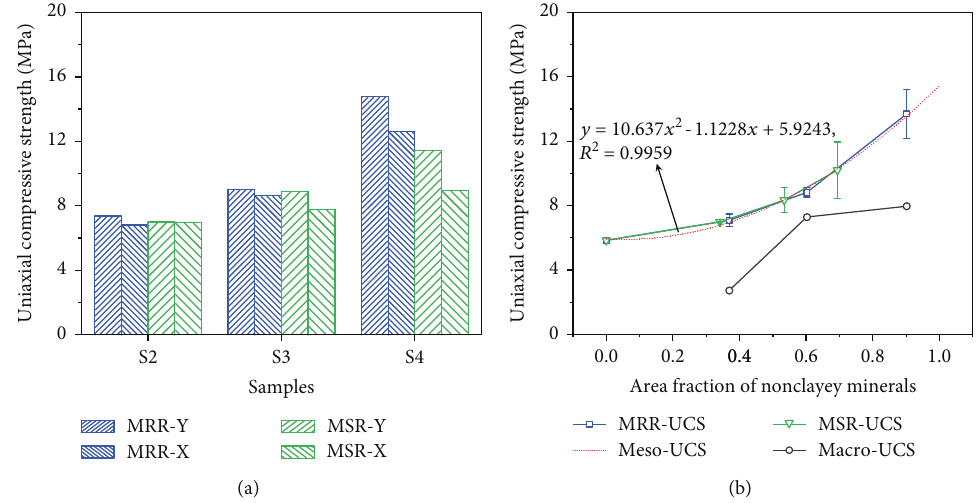
Figure 9: Uniaxial compressive strength (UCS) of (a) the most representative regions (MRRs) and (b) the most special regions (MSRs) under two loading